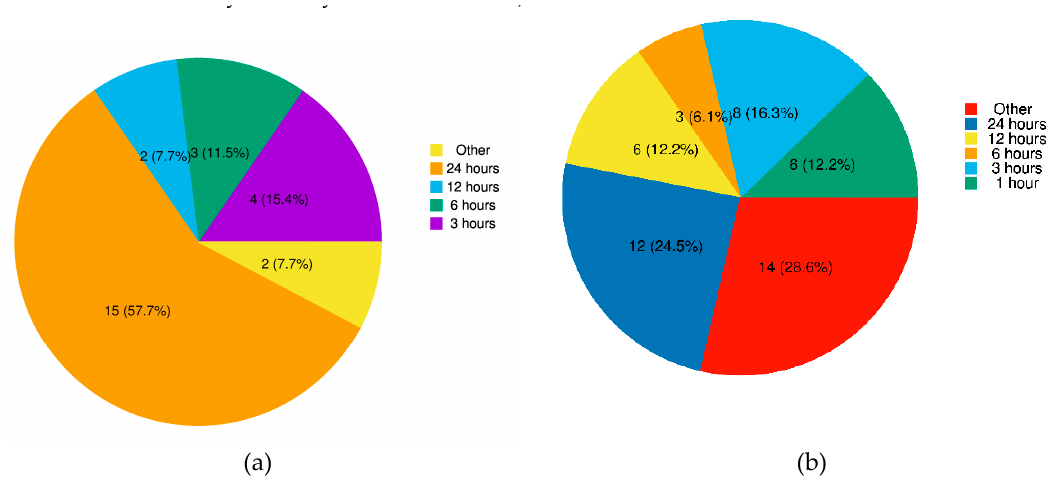
Figure 5. Update frequency for snow data assimilation ( a ) and observation latency ( b ).